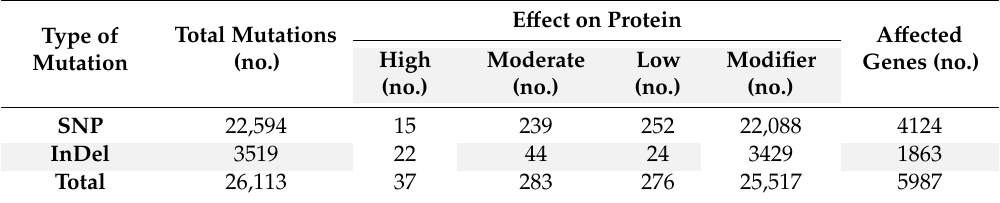
Table 3. Classification of the e ff ect of SNPs / InDels detected in the analysed genotypes. The impacts of the mutations were categorized with four di ff erent tags: high, moderate, and low modifier e ff ect. The total number of genes a ff ected by one or more mutations is also